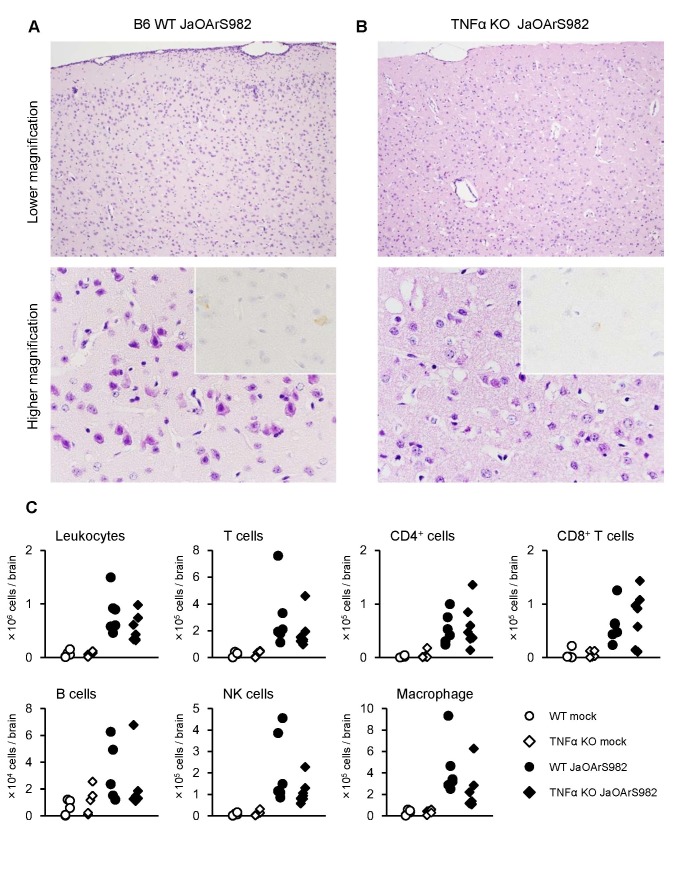
Neuronal degeneration and inflammation in the brains of TNF-α KO mice infected with JaOArS982.(A and B) Histopathological features of WT (A) and TNF-α KO (B) mice infected with 104 pfu of JaOArS982 at 10 days pi. JEV antigens were detected using E-protein specific JEV antibody (insets). Each experiment represents six and five mice of WT and TNF-α KO, respectively. Inflammatory reactions and neuronal degeneration were seen in the WT mice. The TNFa KO mice showed acute necrotic changes in the brain cortex. (C) Number of infiltrating leukocytes, T cells (CD3+), CD4+ T cells, CD8+ T cells, B cells (CD19+), NK cells (NK1.1+) and macrophages including microglia (F4/80+) in brains of WT (mock: n=5, Day 10: n=6) and TNF-α KO (mock: n=5, Day 10: n=7). p: Mann Whitney test.